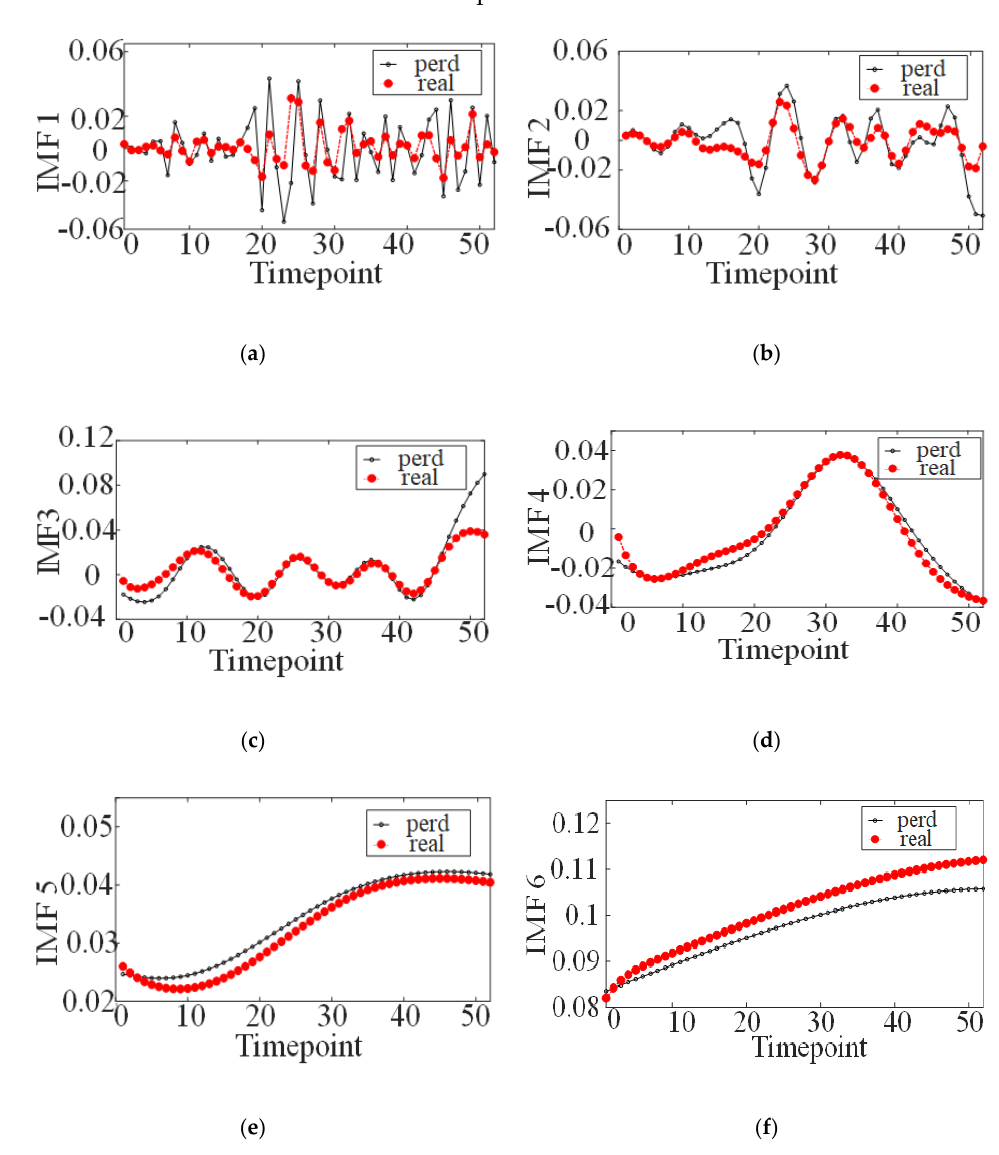
Figure 16. Prediction results of each modal component of the CDI. ( a ) is the prediction result of IFM1; ( b ) is the prediction result of IFM2; ( c ) is the prediction result of IFM3; ( d ) is the prediction result of IFM4; ( e ) is the prediction result of IFM5; ( f ) is the prediction result of IFM6.